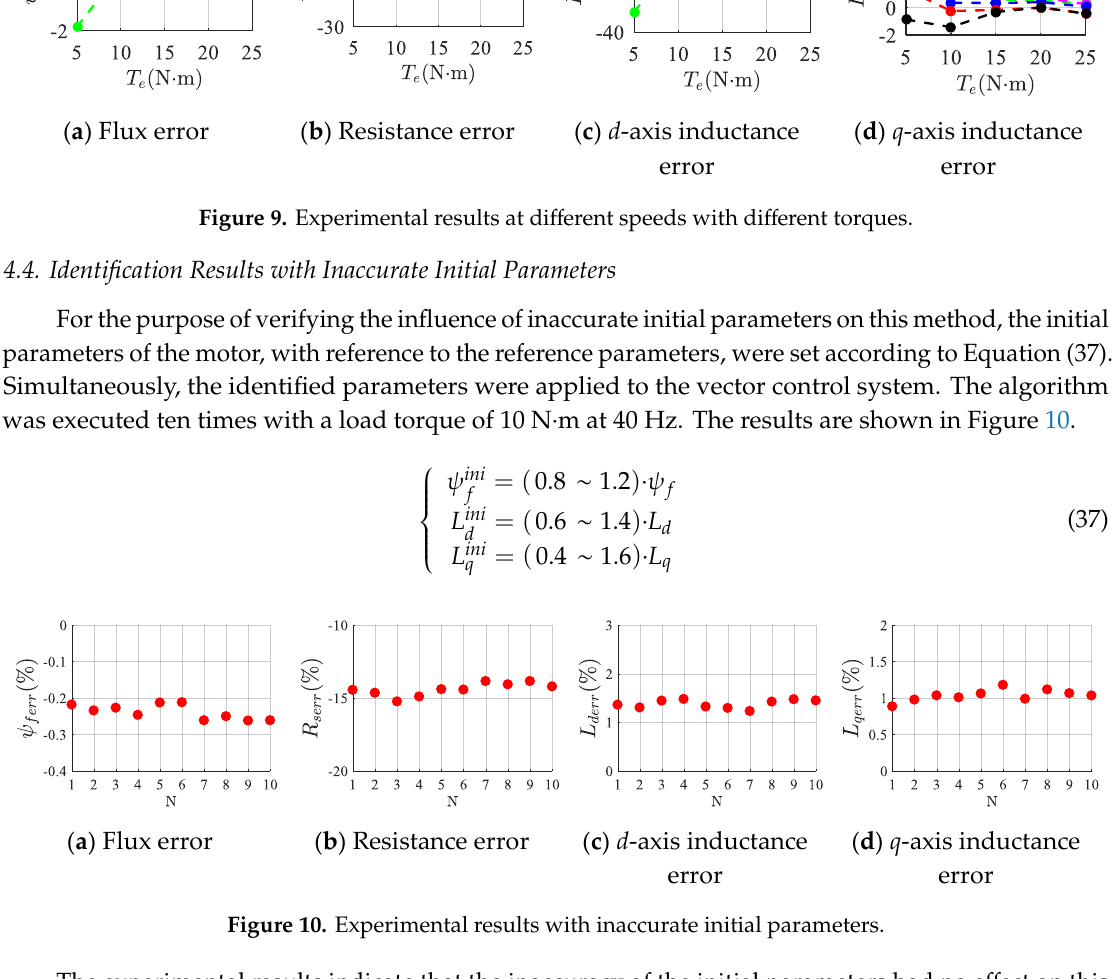
s 1 err . Other errors, which were inversely proportional to the rotor speed according to